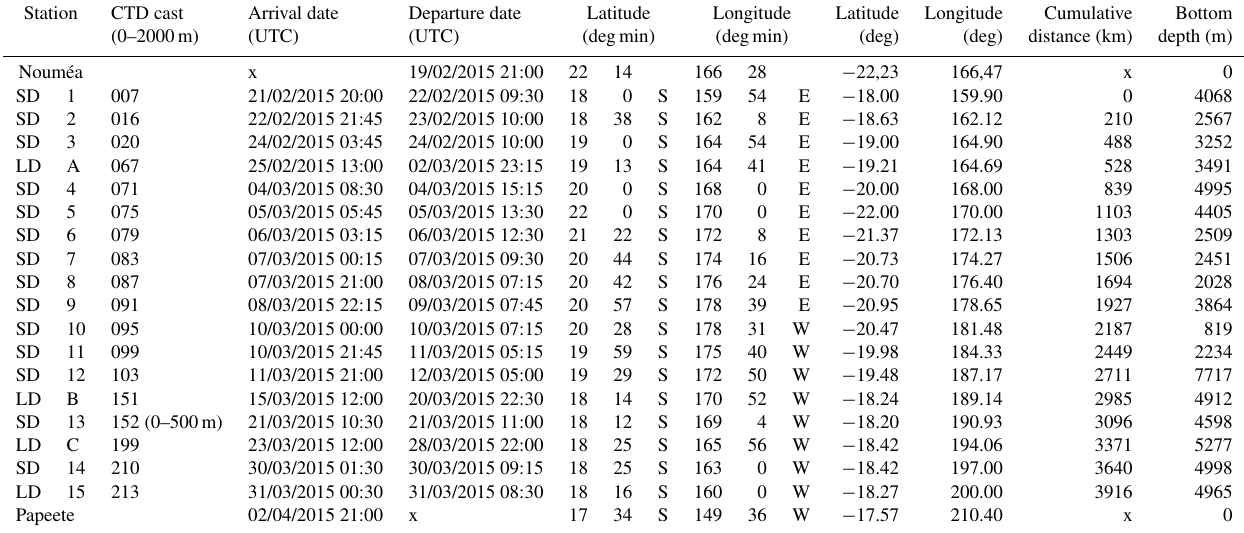
Table 1. Date, location, and general characteristics of the stations investigated along the OUTPACE transect. Distance in kilometers from the first SD station